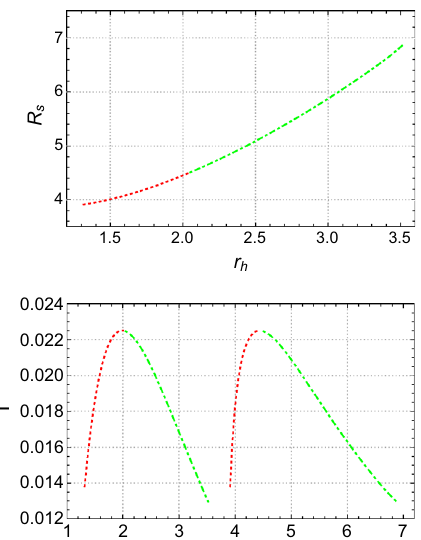
Fig. 5 The upper diagram shows the relation between the shadow radius and the event horizon for the Kerr-dS black hole. The bottom diagramshows thetemperatureintermsoftheeventhorizon(leftcurve) and the shadow radius (right curve) for the black hole, respectively. We set r O = 5 , J = 1 , θ O = π/ 2 , (cid:13) = 0 . 03. The red and green curves in the top diagram correspond to the curves with the same colours in the bottom diagram